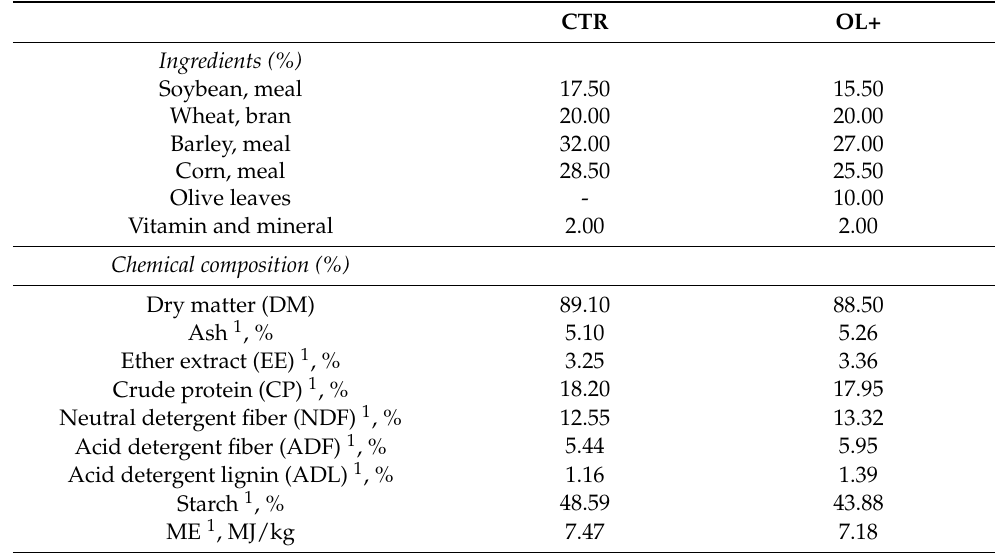
Table 1. Ingredient and chemical composition of the concentrate for control group (CTR) and experimental group